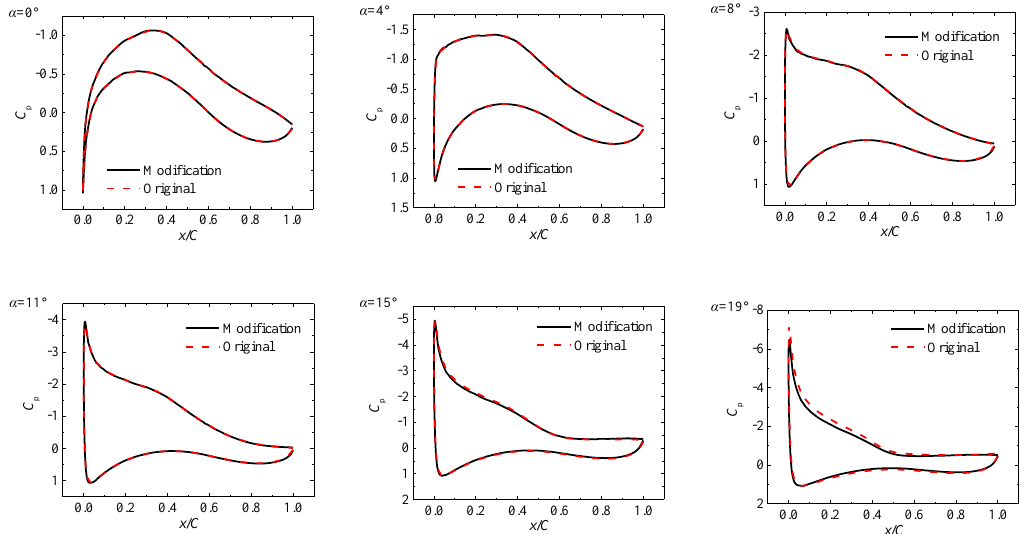
Figure 10. Aerodynamic performance comparison of the airfoil with and without the NLPS.